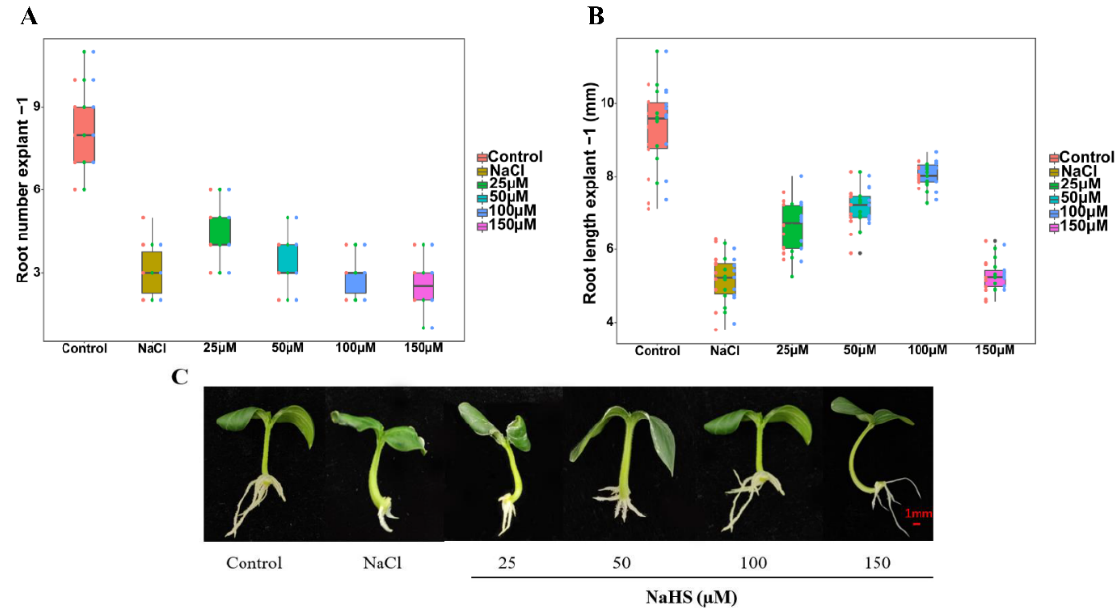
Figure 2. Effects of different concentrations of NaHS on adventitious root development in cucumber explants. The primary roots were removed from the hypocotyl of 5-day-old seedlings. Explants were incubated for 5 days with distilled water (the control) and different concentrations of NaHS (25, 50, 100, and 150 µ M) + 10 mM NaCl. The number ( A ) and length ( B ) of adventitious roots were expressed as mean ± SE ( n = 3, 10 explants were used per replicate). Values are means of three independent replicates. Photos [overall plant morphology ( C )] of the plants were taken 5 days after